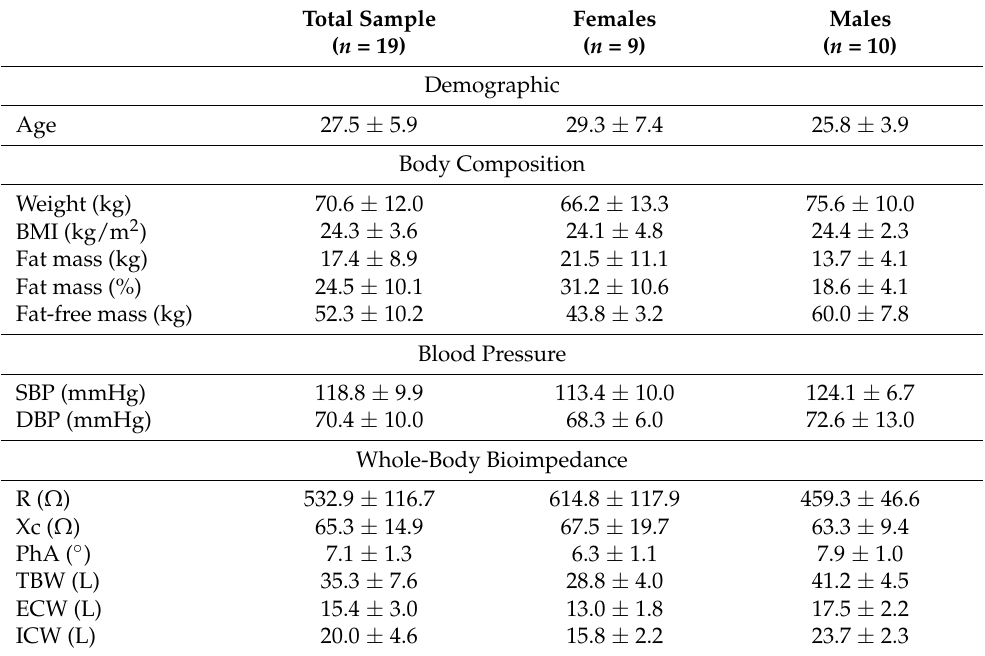
Table 1. Characteristics of